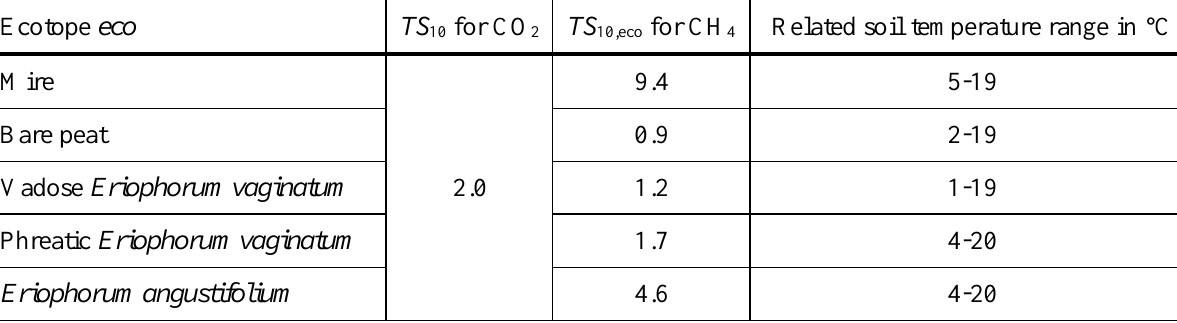
Table 9. Estimates of soil temperature sensitivity coefficient TS 10 for CO 2 and CH 4 fluxes to the atmosphere from different ecotopes based on the linear mixed effects models. Due to limited data material, no TS 10 estimates are shown for the lake and pond